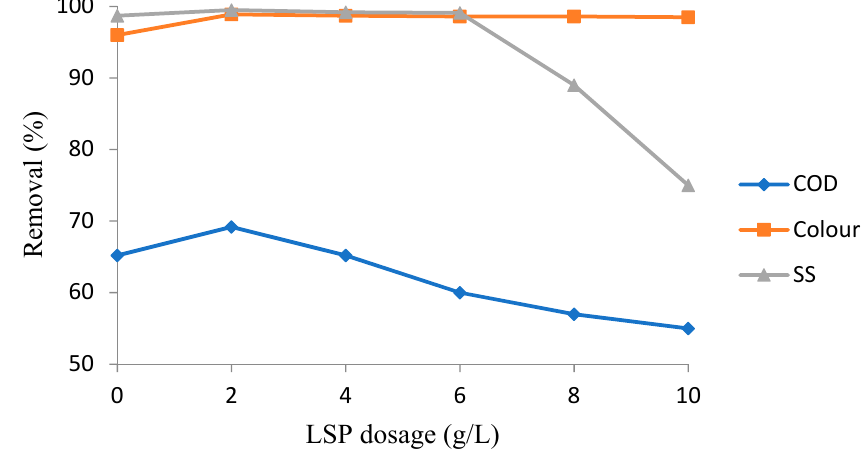
Figure 9. The effect of LSP as coagulant aid on the removal of color, SS, and COD at a constant pH 6 and using 2.75 g/L of PACl dosage.